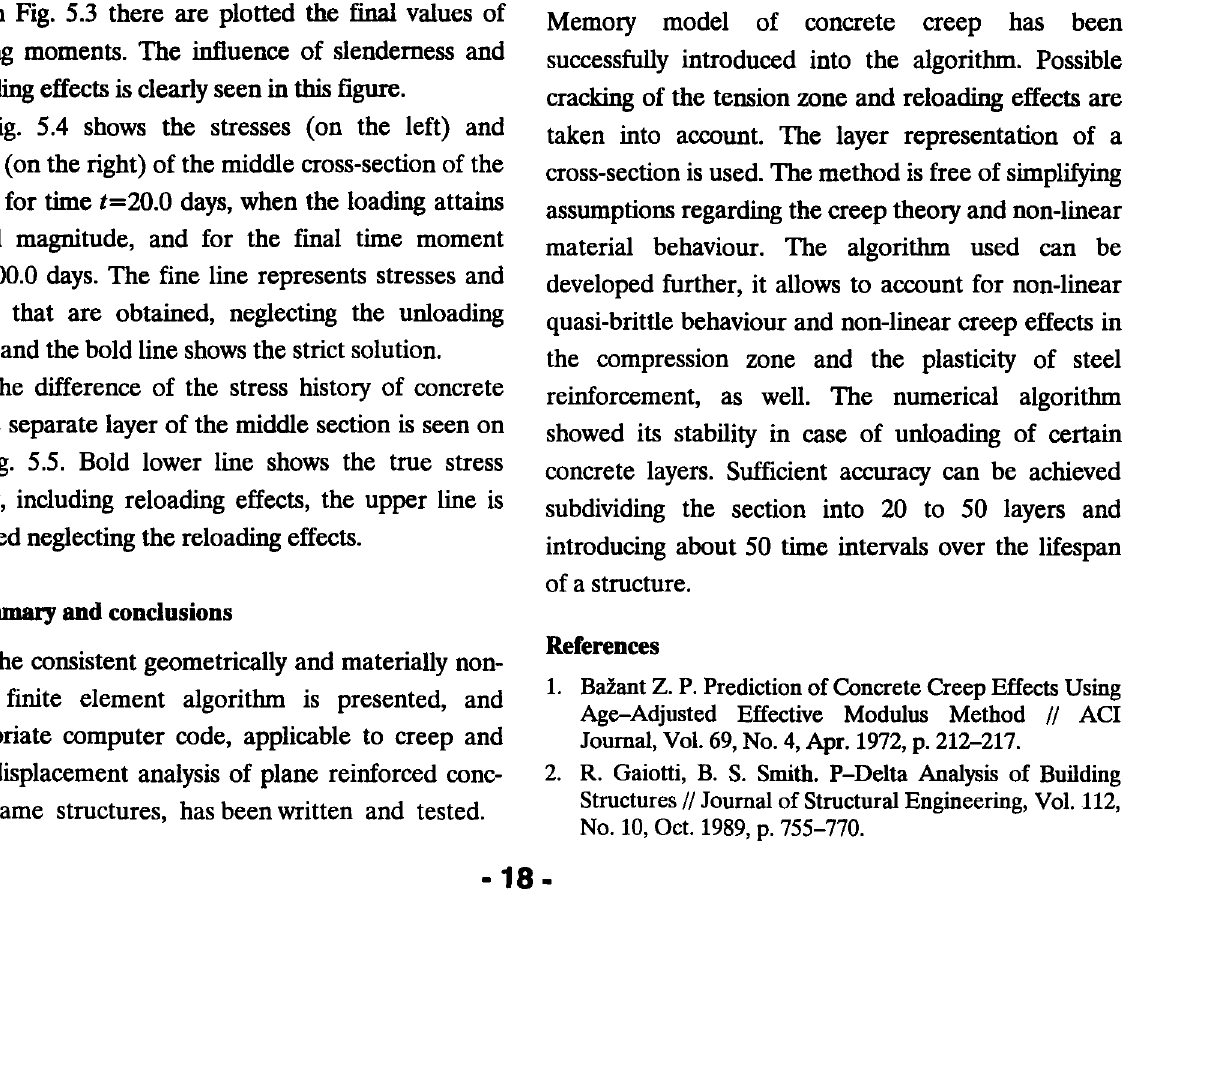
Fig. 5.3. Redistribution of bending moments at time t=10000 days. Bending moments: when geometrical non-linearity is neglected (upper graph); in lower graph geometrically non-linear solution is shown. In brackets are written bending moments with the account of the reloading effect